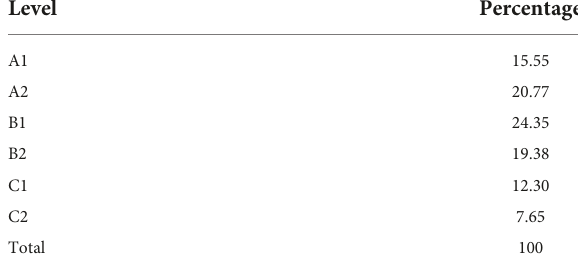
TABLE 3 Evaluation of content creation